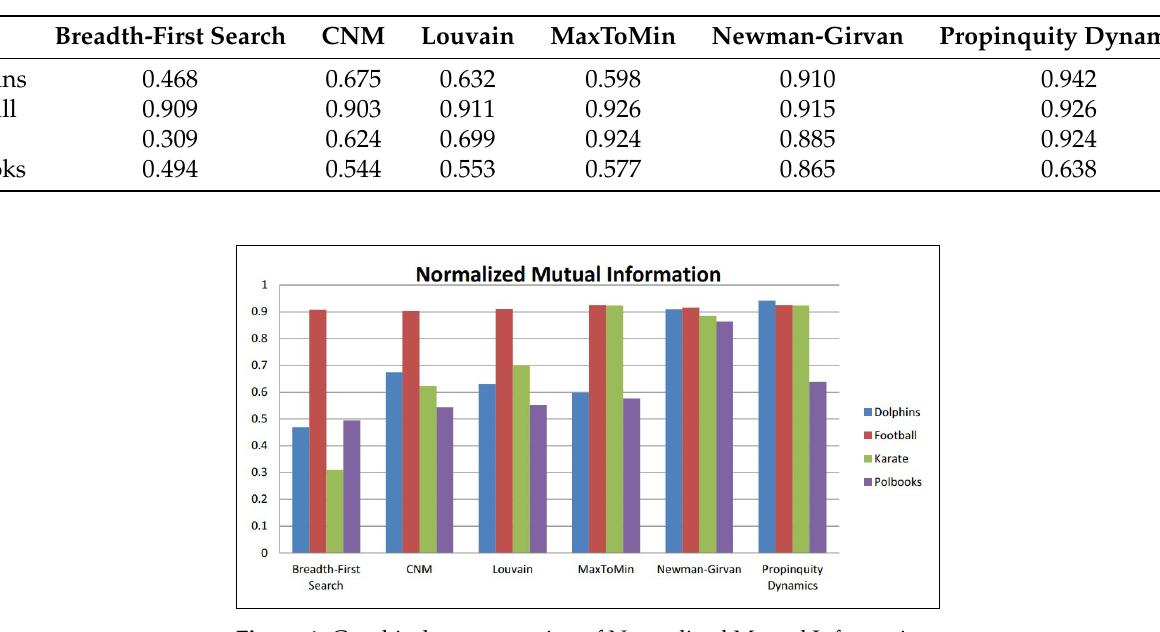
Figure 1. Graphical representation of Normalized Mutual Information.